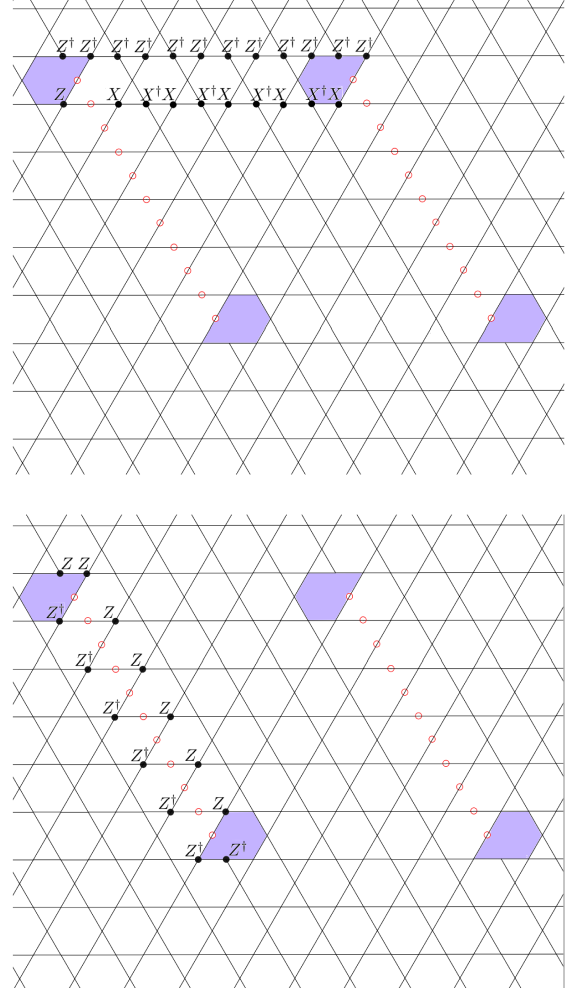
FIG. 4. Strings of alternating single-qudit operators of the form ω 5 = 2 Y Z † H : c : or ω 5 = 2 X þ H : c : (encircled) are added to the i þ i i Hamiltonian. These effectively eliminate the qudits on which they act from the code, leading to enlarged, pentagon-shaped stabi- lizers along the defect string. Parafermion modes reside on the pentagons at the ends of the defect strings (shaded areas). ~ X A possible choice for two logical operators (top panel) and L ~ Z ~ X ~ Z ~ Z ω ~ X (bottom panel) satisfying is L L L ¼ L L